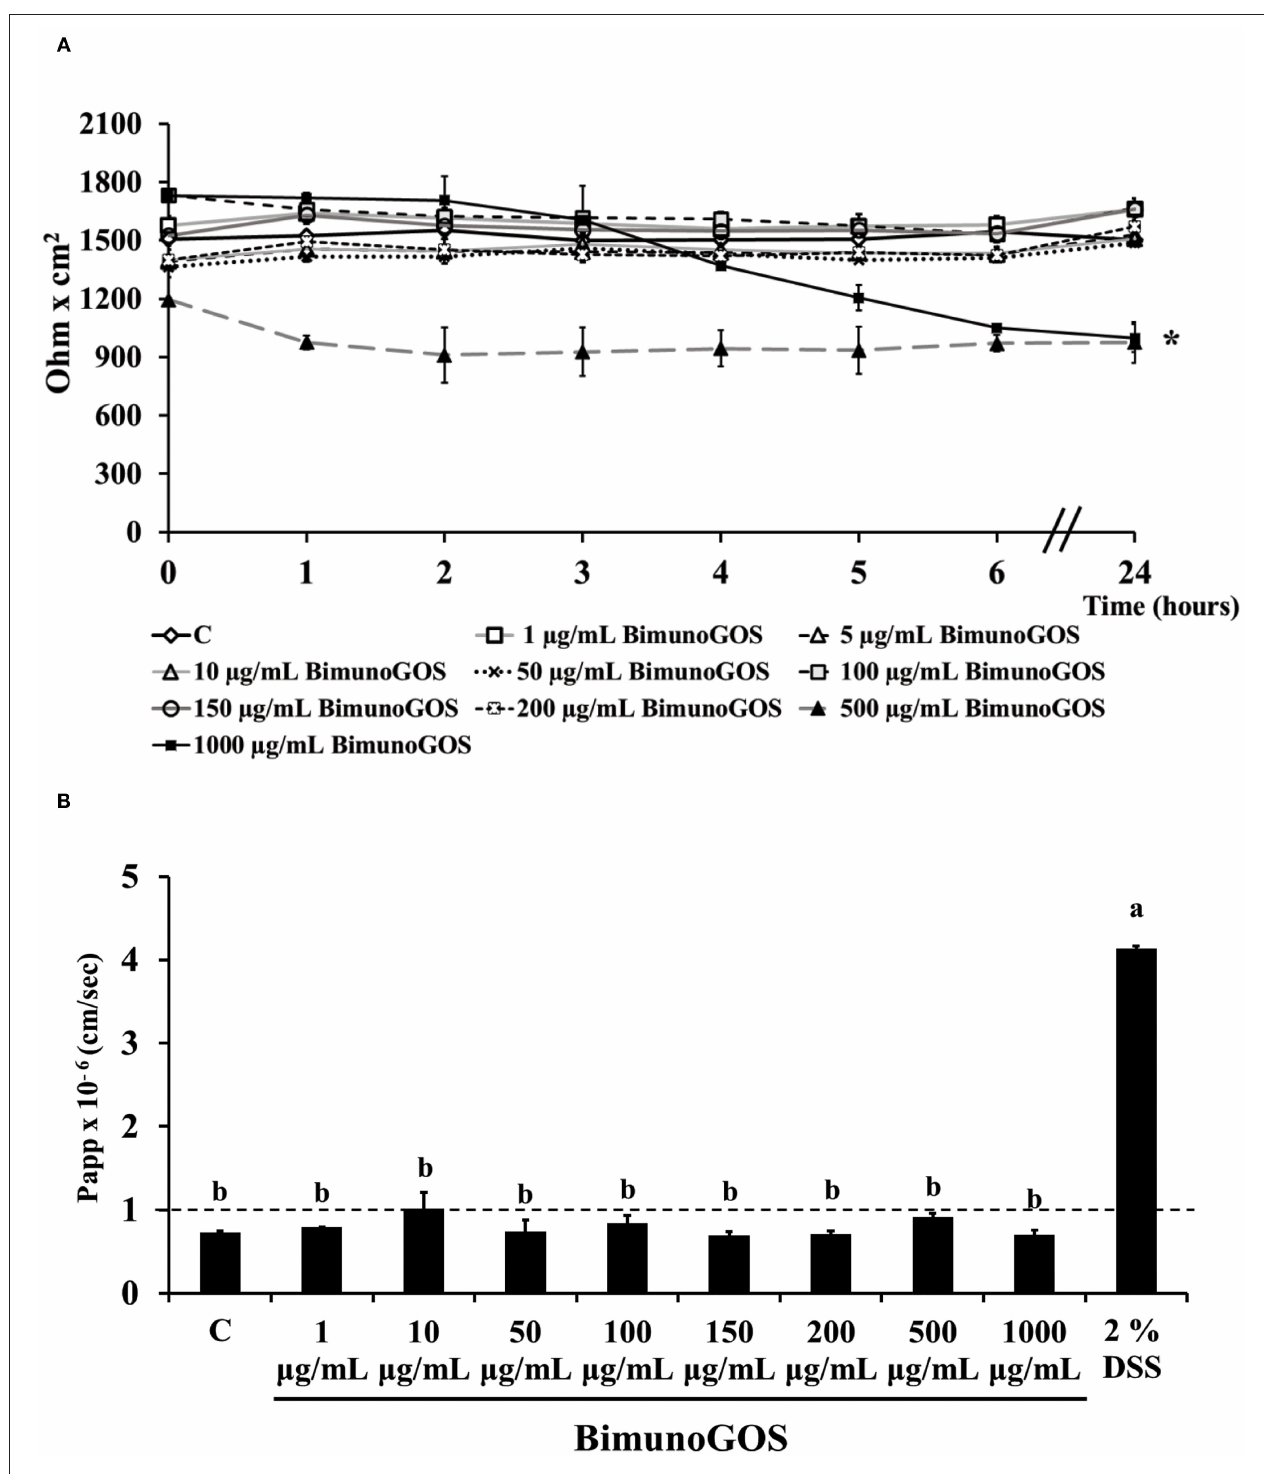
FIGURE 2 | Bimuno GOS effects on membrane barrier of Caco-2 cells. Transepithelial electrical resistance (TEER) (A) and phenol red apparent permeability (Papp) (B) . Cells were untreated (Control, C), treated with different Bimuno GOS concentrations (1–1,000 µ g/ml), or treated with 2% DSS. TEER values are reported as Ohm × cm 2 . Phenol red Papp was measured after 24h treatment with Bimuno GOS or after 6h treatment with DSS, and values are reported as cm/s. Values represent mean ± SD of at least three independent experiments, carried out in triplicate. (A) *Stands for significant difference between T0 and T24 ( P < 0.001). (B) Means without a common letter significantly differ, P <